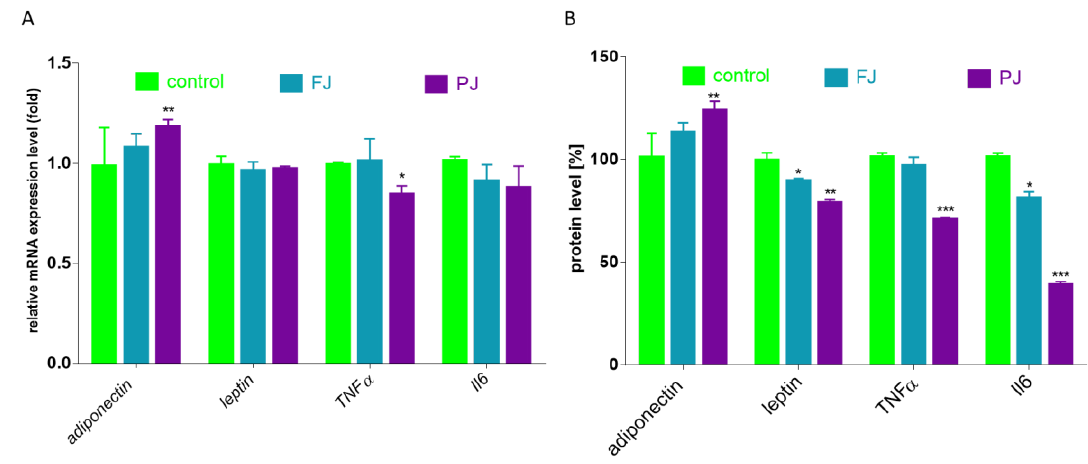
Figure 11. Influence of V. opulus FJ and PJ preparations on the mRNA expression ( A ) and protein secretion ( B ) of selected adipokines and cytokines in differentiated 3T3-L1 cells; control cells were not exposed to any compound; values are means ± standard deviations, n = 6; statistical significance was calculated versus control cells * p ≤ 0.05, ** p ≤ 0.01, *** p ≤ 0.001.